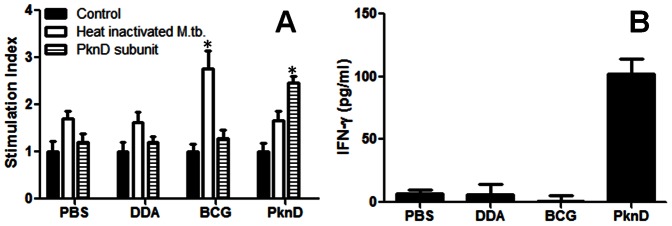
PknD vaccination induces specific IFN-γ and IgG responses.Splenic recall assays were performed on splenocytes from guinea pigs vaccinated with BCG, recombinant PknD, DDA (adjuvant alone) or PBS (unvaccinated controls). The WST-1 system was then used to measure proliferation after stimulation heat-inactivated M. tuberculosis (white bars), recombinant PknD subunit (striped bars) or control with culture media alone (black bars) (panel A). Significant cellular proliferation in response to PknD subunit was only observed in splenocytes from PknD vaccinated animals (P = 0.002). Similarly, significant proliferation in response to heat-inactivated M. tuberculosis was only observed in splenocytes from BCG vaccinated animals (P = 0.01). Supernatants from these assays were also used to measure the IFN-γ levels (panel B). Consistent with proliferation data, only animals vaccinated with PknD (P<0.01) generated appreciable levels of IFN-γ in response to the PknD subunit protein (Figure 2B). Splenocytes from three animals from each group were tested. Each assay was performed in triplicate. Data are presented on a linear scale as mean±standard deviation.